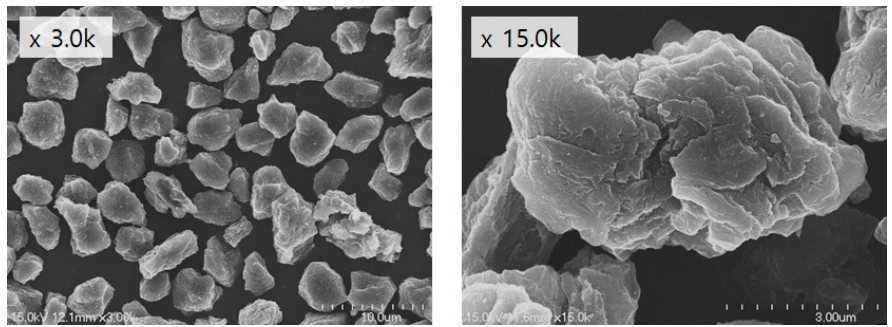
Figure 2. SEM images of the polycrystalline diamond abrasive.